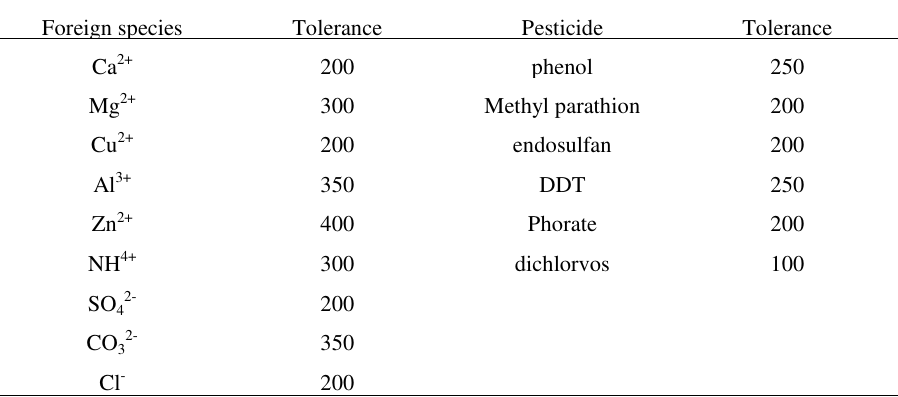
*Tolerance limit, which caused up to ± 2% error in % recovery